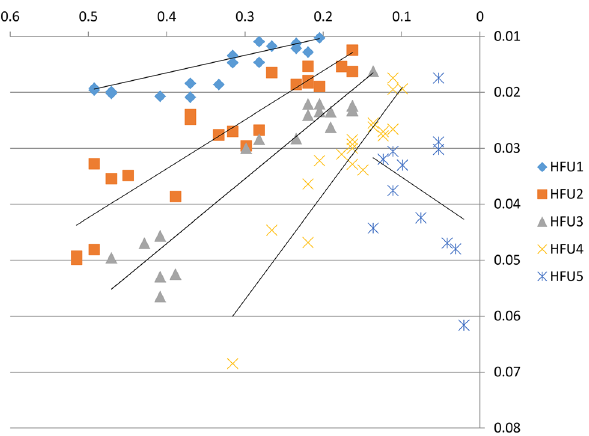
Fig. 14 RQI vs. ϕz indicating five hydraulic fluid units (HFU) in five sandstone